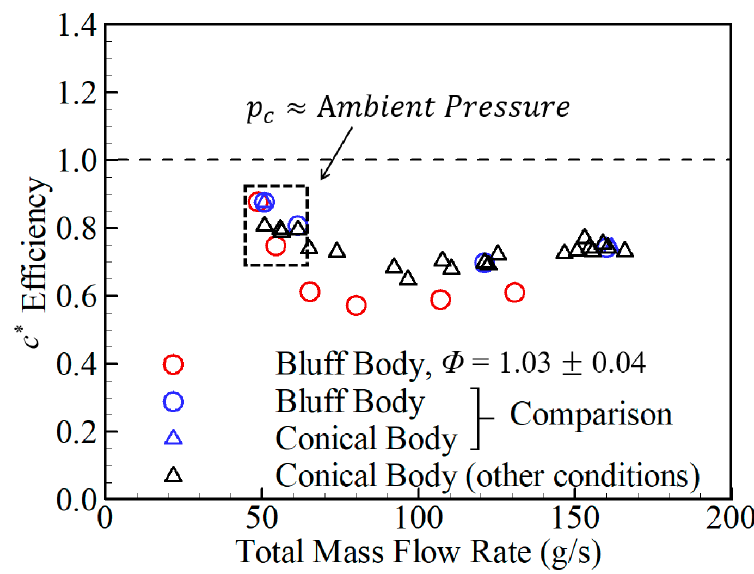
Figure 14. Characteristic velocity efficiency.